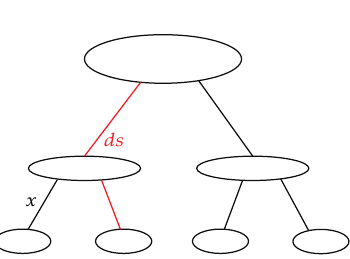
Figure 1: Schematic diagram of hierarchic gas di ff usion path in cocoon